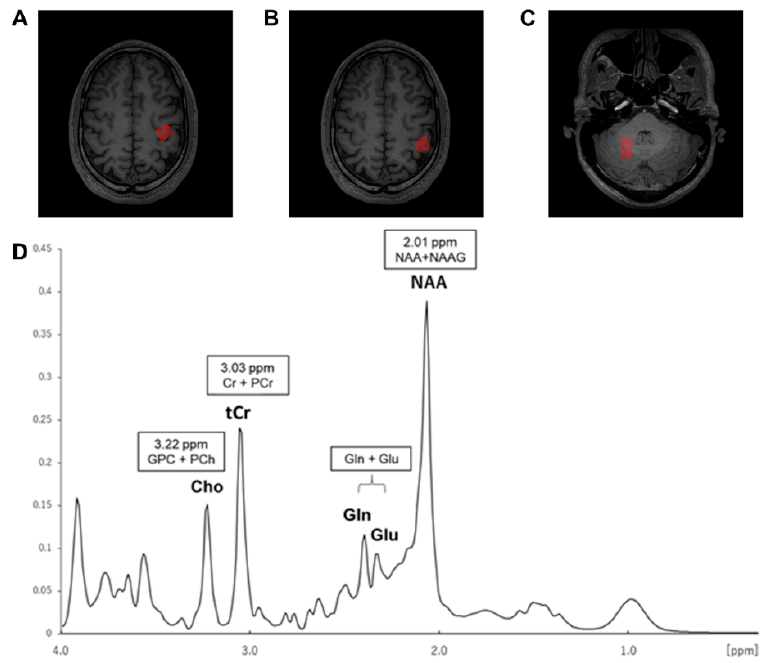
Figure 3. Overview of the voxel positions and representative spectrum obtained from the left M1.